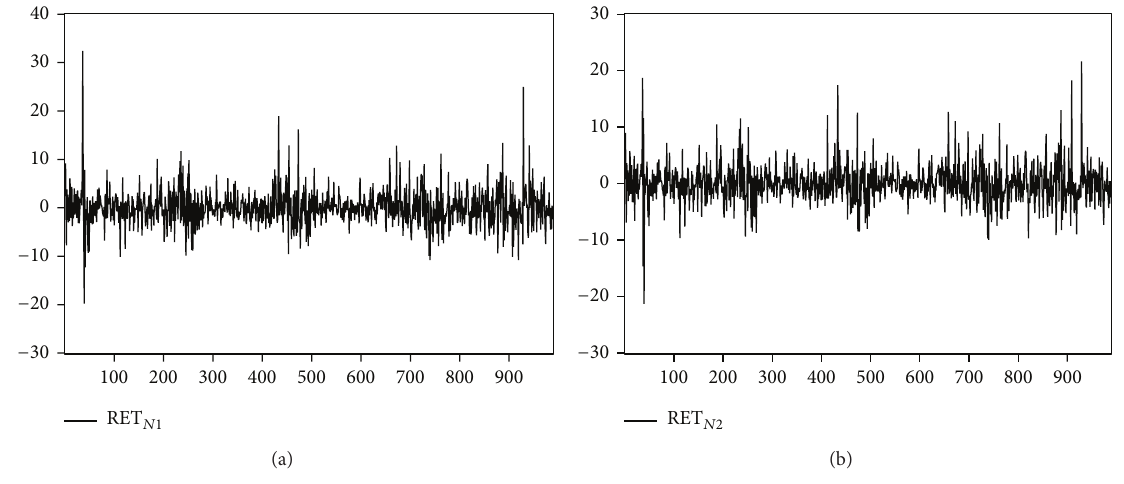
Figure 1: Return of natural gas: (a) near-month and (b)